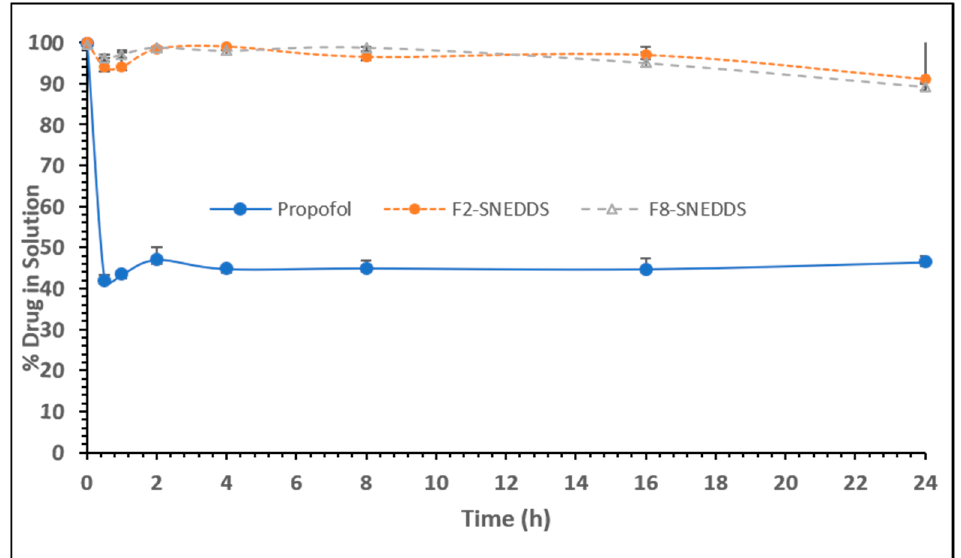
Figure 7. Percentage of propofol remaining in solution during 24 h after a dynamic dispersion study carried out with representative SNEDDS formulations. The formulations are F2-SNEDDS, M810/CMCM/KHS15 (35/15/50), and F8-SNEDDS, ZRO/M35-1/KHS15 (35/15/50) %w/w/w, respectively. Data are expressed as mean ± SD, n = 3.